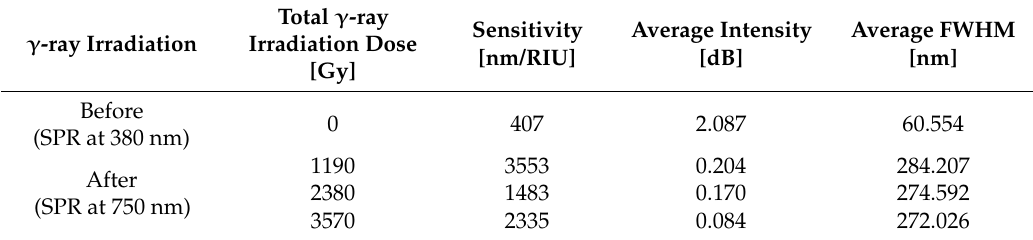
Table 1. The SPR sensitivity, the average intensity, and the average FWHM of the optical fiber embedded with Au NPs in cladding after the γ -ray